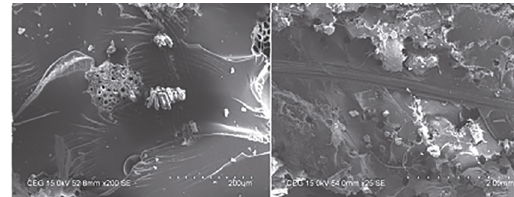
Figure 19: SEM micrographs of carbon/banana fiber composites subjected to flexural loading